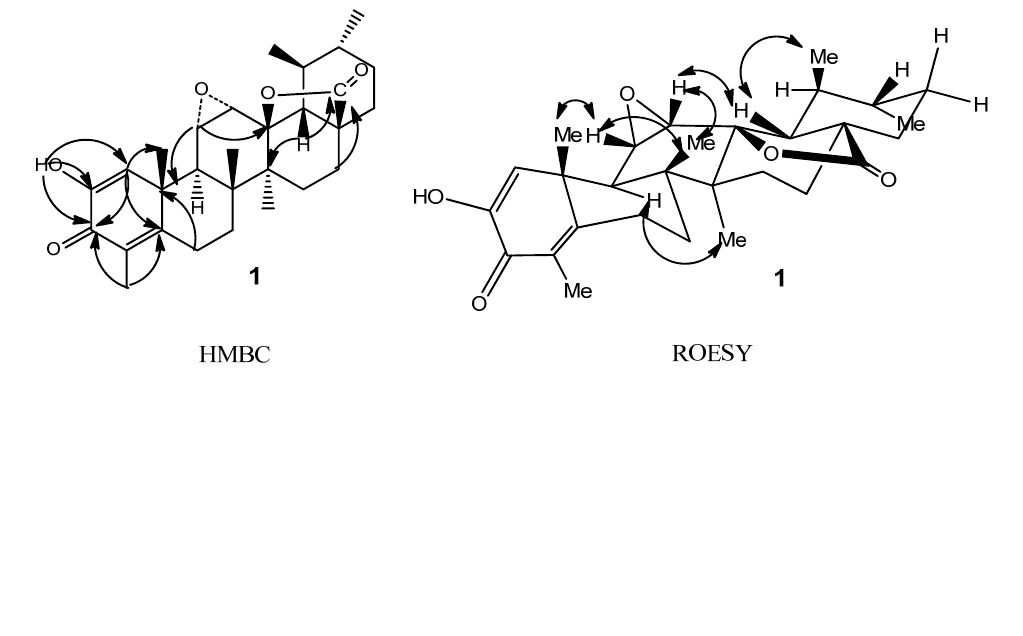
Figure 2. Key HMBC and ROESY correlations of 1